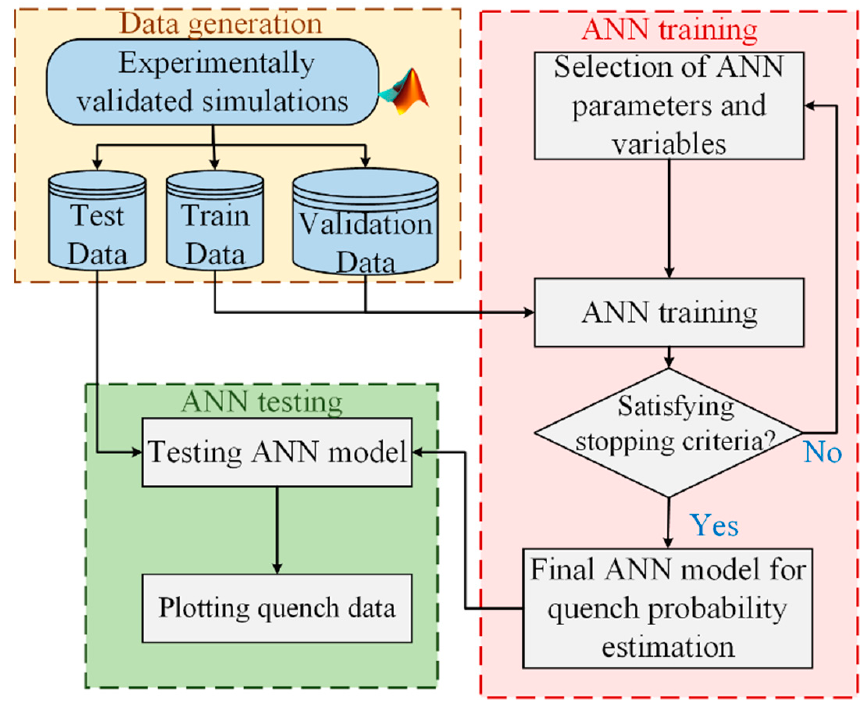
Figure 5. The structure of the proposed ANN-based model for quench probability estimation. For quench probability estimation, eight inputs for the ANN-based model were con- sidered in this paper, namely, operating current, operating temperature, tape width, tape thickness, stabilizer thickness, superconducting layer thickness, shield thickness, and sub- strate thickness. It should be noted that the training data as well as validation and test data are provided based on the analytical method, as explained in Section 2. The importance of developing an ANN-based model for quench probability estimation, instead of continuing to work with the analytical model, is due to the adaptability and updatability of the ANN model. This means that the proposed ANN-based model could be updated and adapted in future based on any new data fed into the model. This is an excellent aspect for any model to be fitted with new requirements and properties of HTS tapes or even HTS